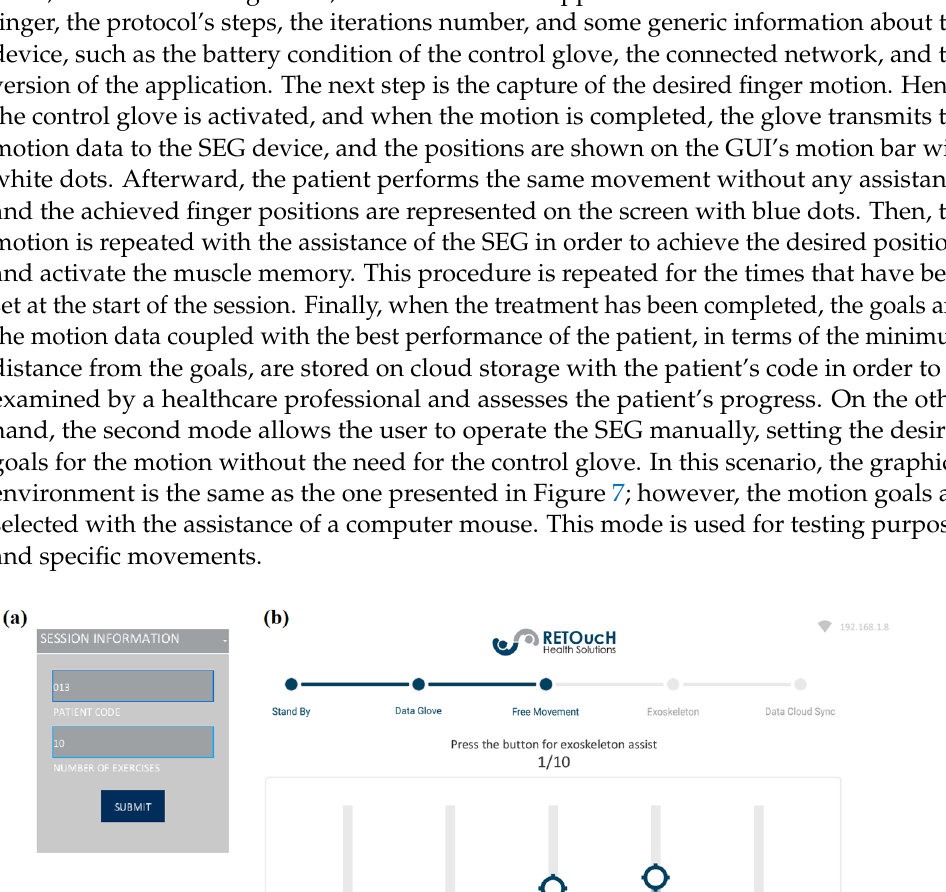
Figure 8. ( a ) Final configuration of overall SEG device along with its main components; ( b ) Illustra- tive flowchart of the SEG device function.